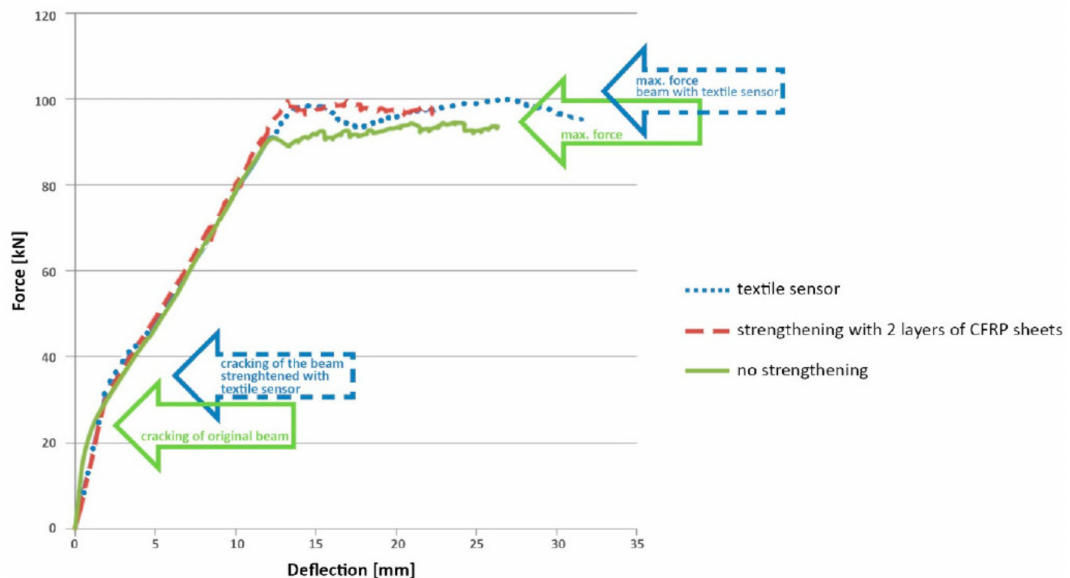
Figure 27. External load with a deflection for the 3 types of beams: without strengthening, with CFRP strengthening and with textile sensor strengthening. Reproduced with permission from [75], MDPI,